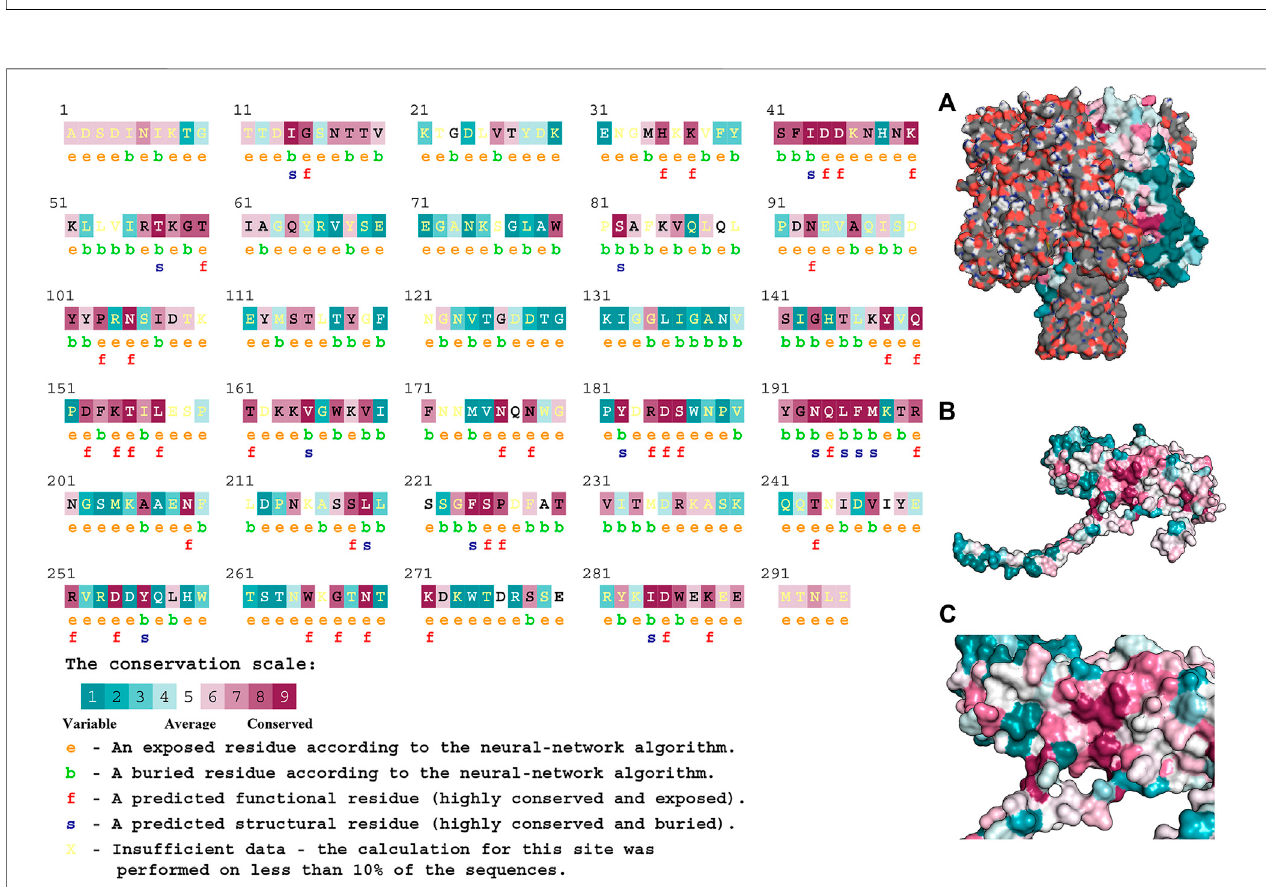
FIGURE 7 | Structural characteristics of Hla protein. Note: (A) presents the heptameric structure of Hla; (B) and (C) presents Hla monomer.